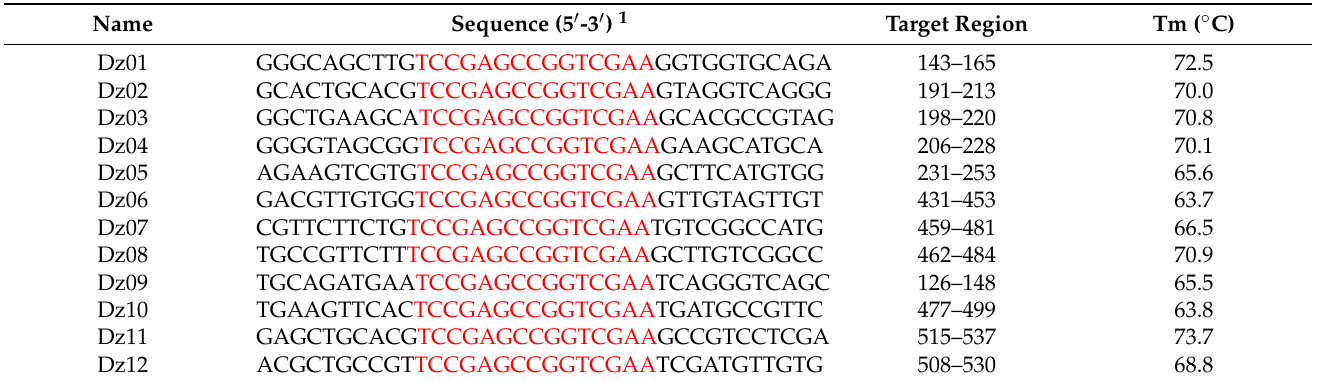
Table 1. The sequences of twelve Dz8–17 enzymes targeting EGFP